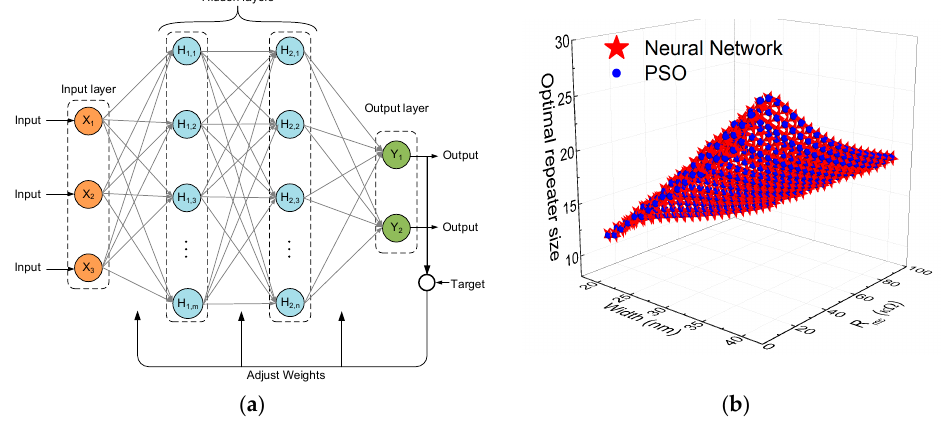
Figure 13. ( a ) Schematic of the back propagation neural network. ( b ) Optimal repeater size of MWCNT interconnects obtained using the PSO algorithm and trained neural network [90].